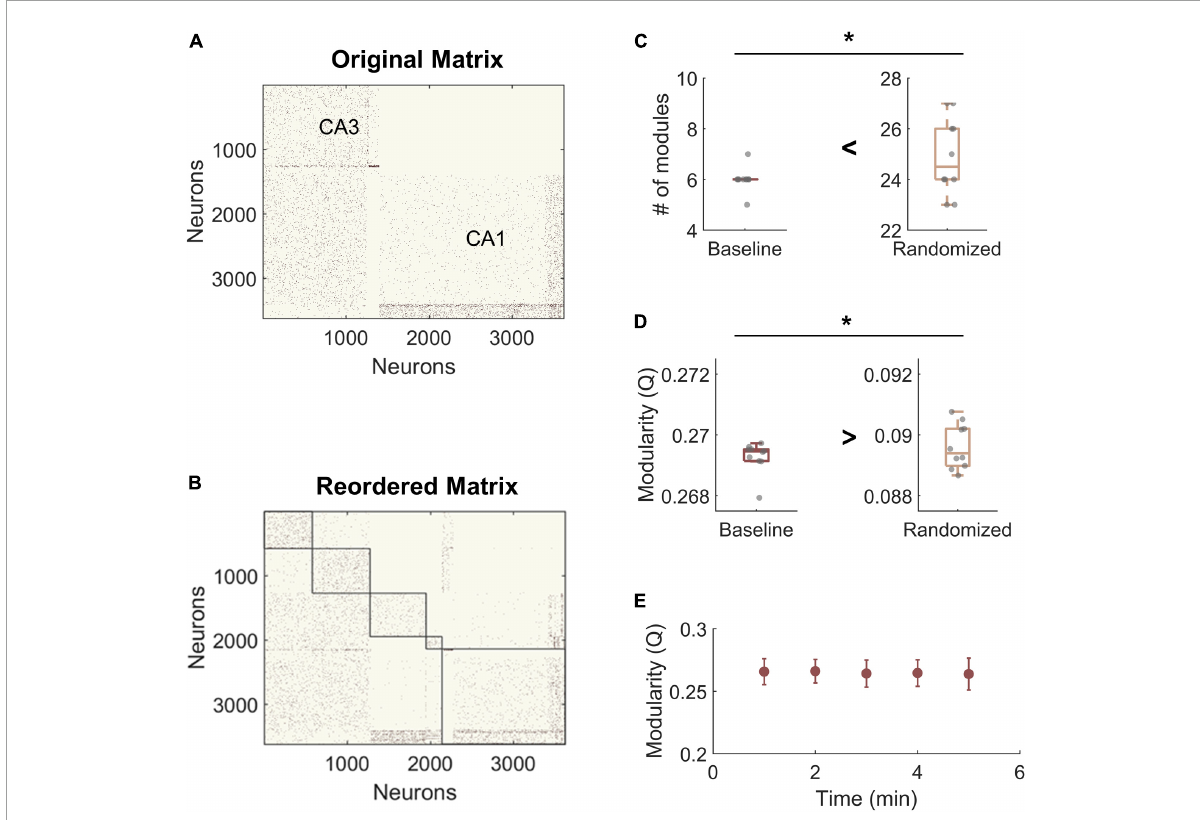
FIGURE3 Hippocampal model networks have significant community structure compared randomized control networks. (A) A representative baseline network organized by anatomical structure (CA3 vs. CA1). (B) A representative network reorganized by module. (C) The number of modules is significantly higher in the randomized networks than at baseline ( p < 1e-5). (D) Modularity, Q, is significantly lower for randomized networks ( p < 1e-5). Randomized controls rewired connections in the original network while preserving the degree distribution. (E) There was no significant change in modularity over time at baseline. * p <